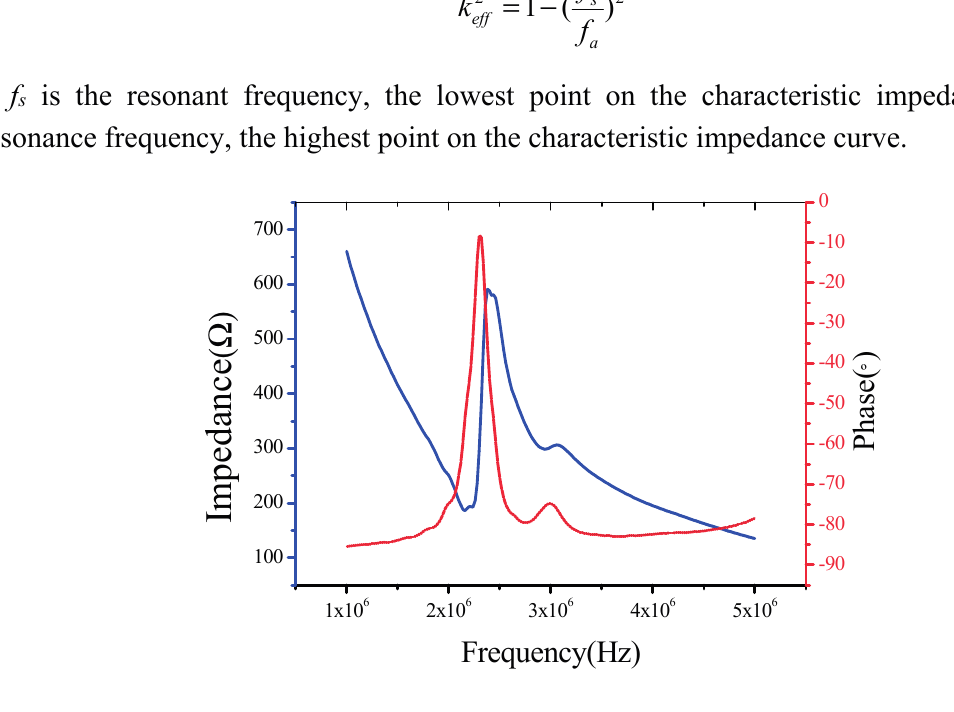
Figure 5. The experimental results of impedance and